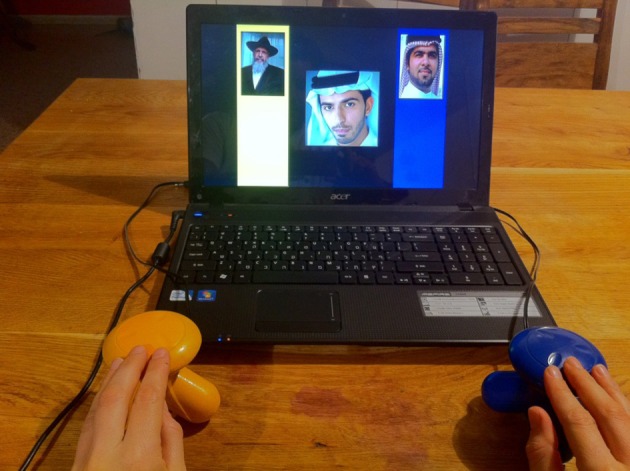
Picture of the experimental set-up for the IAT.